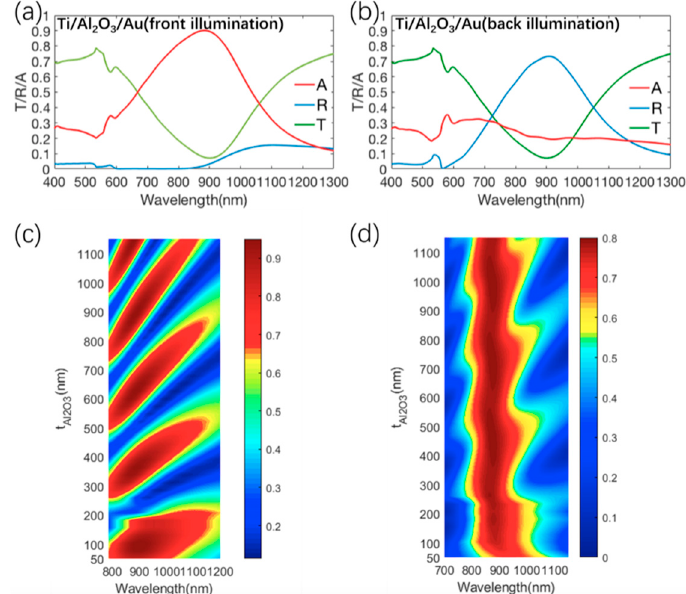
Figure 2. ( a ) Simulation absorption/transmission/reflection spectra of the metasurface consisting of Ti/Al 2 O 3 /Au structure for front illumination ( b ) Simulation absorption/transmission/reflection spectra of the metasurface consisting of Ti / Al 2 O 3 / Au structure for back illumination. ( c ) Simulated absorption spectra of the metasurface consisting of Ti / Al 2 O 3 / Au with various t Al2O3 for front illumination. ( d ) Simulated reflection spectra of the metasurface consisting of Ti / Al 2 O 3 / Au with various t Al2O3 for back illumination.